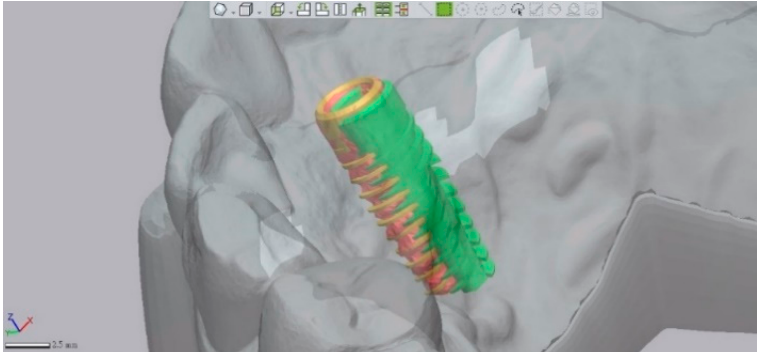
Figure 5. A CAD file (brown) of the implant replaced the ambiguous post-operative CBCT implant image (red) by using the best-fit algorithm, so that the deviation between the planned implant (green) could be more appropriately measured.